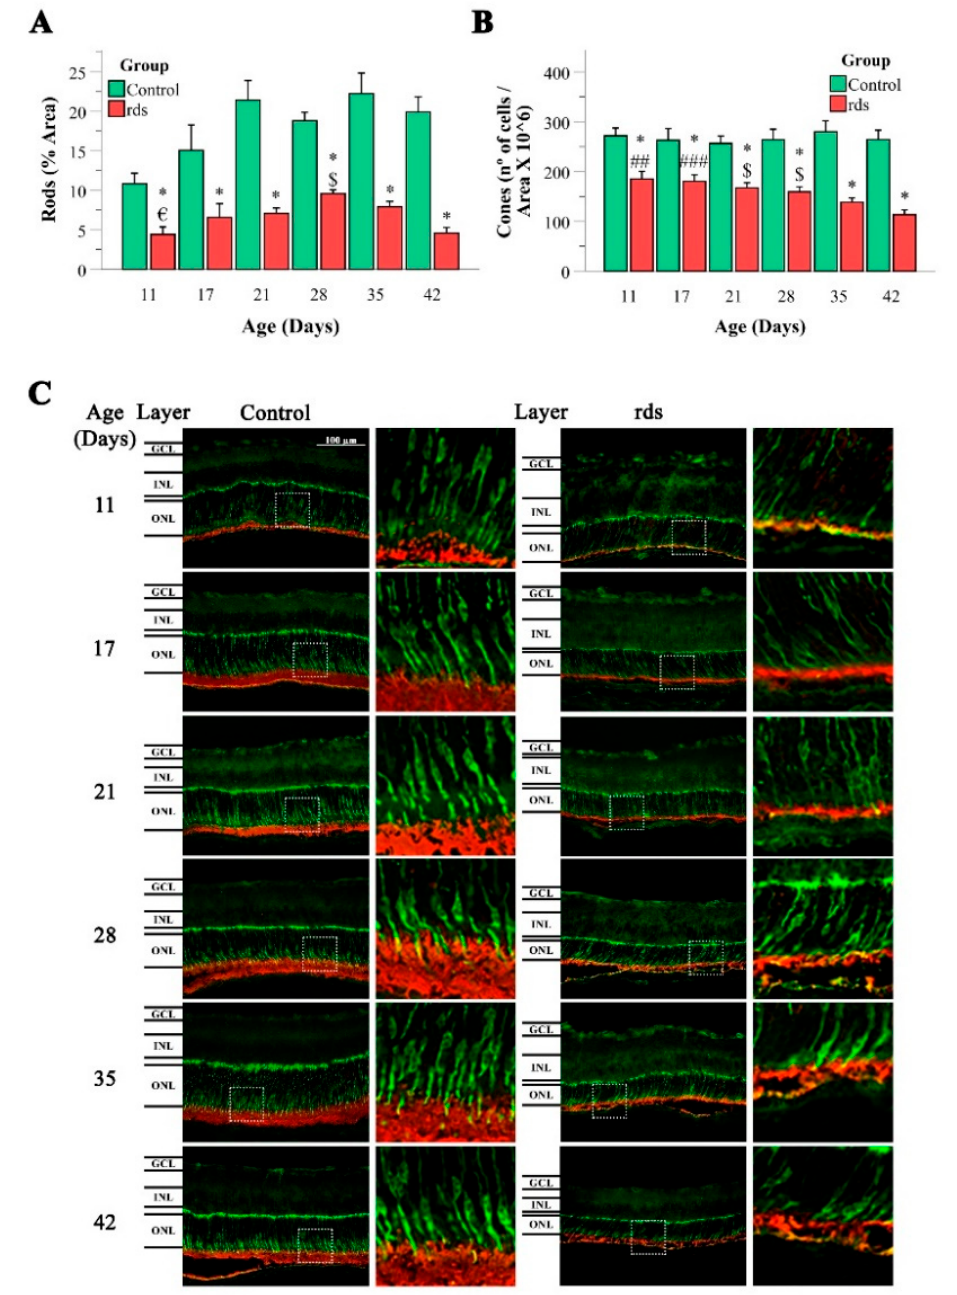
Figure 3. Rhodopsin and cone arrestin staining. ( A , B ) Left side: graphical illustration of the area percentage of rhodopsin staining in control and rds retinas, and graphical representation of the number of rods rhodopsin-labeled cells divided by area per 10 6 (error bars are the standard error of the mean) (* p < 0.0001 vs. control group at the same age; € p < 0.002 vs. rds mice at PN28; $ p < 0.01 vs. rds mice at PN42). Right side: graphical illustration of the number of cells labeled with cone arrestin, divided by area per 10 6 in the three studied areas and at the different postnatal ages. (* p < 0.0001 vs. control group at the same age; ## p < 0.001 vs. rds mice at PN28, PN35, and PN42; ### p < 0.001 vs. rds mice at PN35 and PN42; $ p < 0.01 vs. rds mice at PN42). Four mice per group were used and three histological sections of one retina of each mouse were quantified. ( C ) Microscope 40X magnification photos of rhodopsin and cone arrestin immunostaining in control and rds groups at the different studied ages (rhodopsin in green; arrestin in